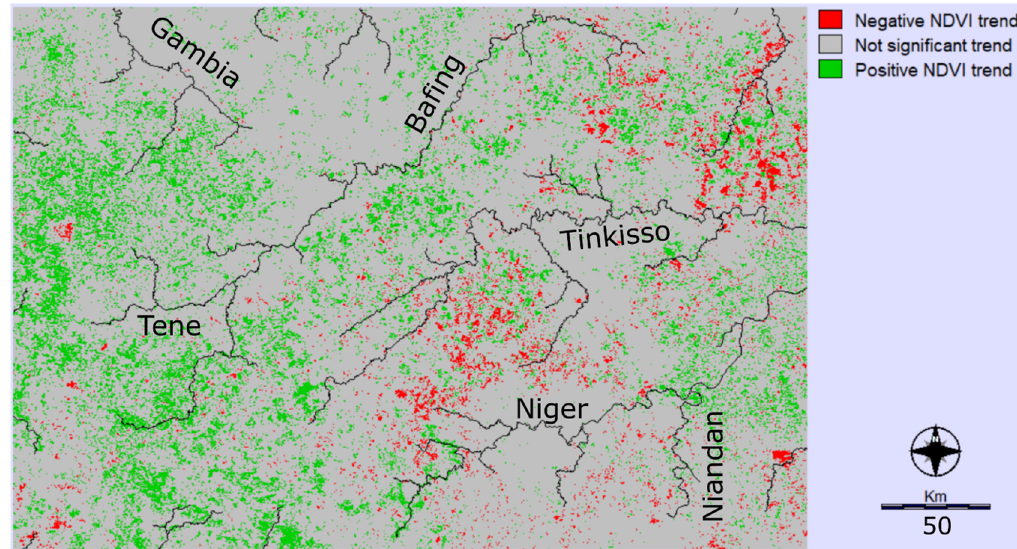
Figure 9. Evolution of vegetation cover (NDVI—normalized difference vegetation index) in the Upper Bafing Basin from February 2000 to February 2020. The area represented is the one of the empty blue rectangle in Figure 7.